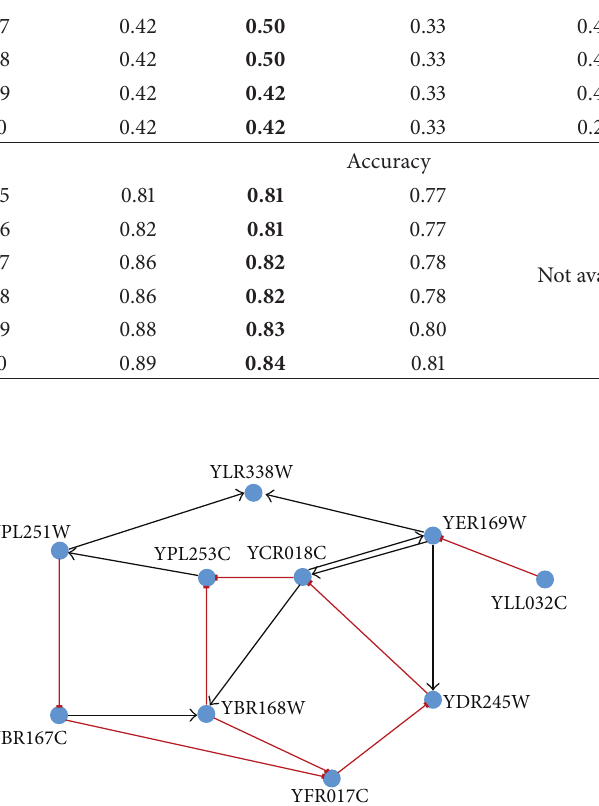
Figure 8: Inferred network obtained by the proposed model for 25 time points.